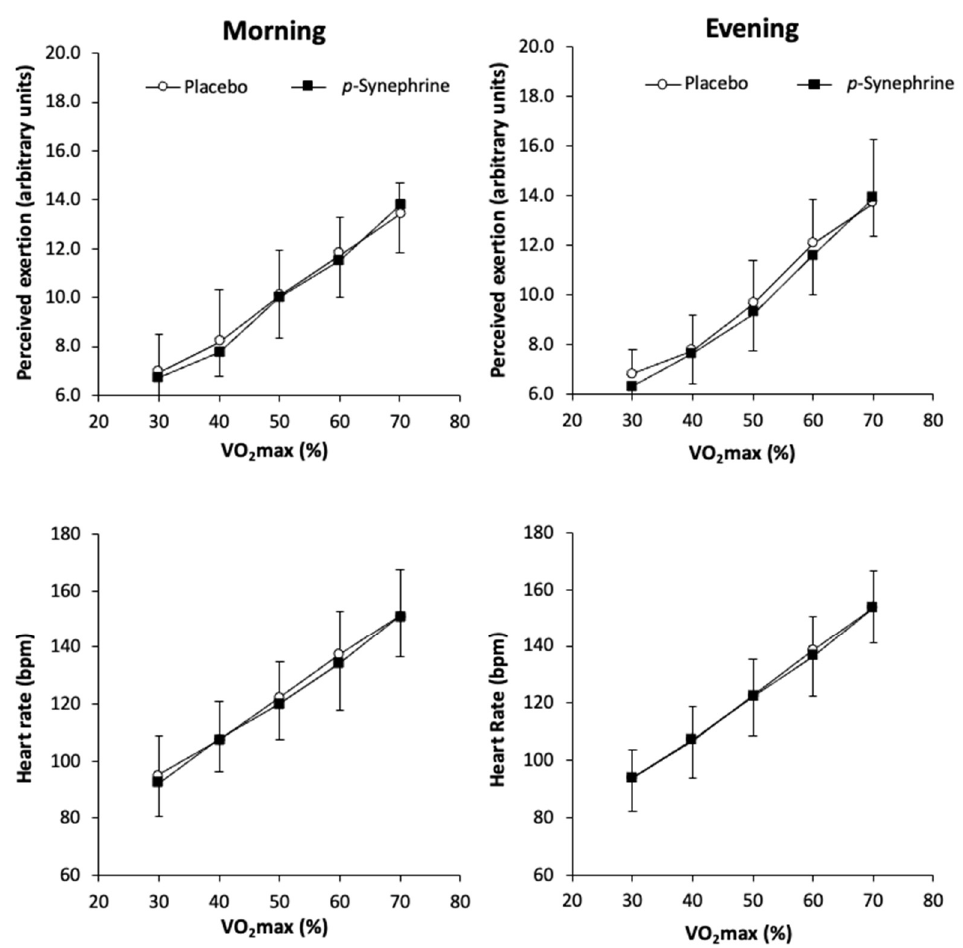
Figure 3. Rating of perceived exertion (in arbitrary units using the 6–20-point Borg scale) and heart rate (in beats per min; bpm) and during exercise of increasing intensity performed in the morning (8:00–10:00 h) or the evening (17:00–19:00 h) after the ingestion of 3 mg/kg of p -synephrine or a placebo in women. Table 2. Magnitude of side effects for the 24 h following the ingestion of 3 mg/kg of p -synephrine or a placebo in the morning (8:00–10:00 h) or evening (17:00–19:00 h) in